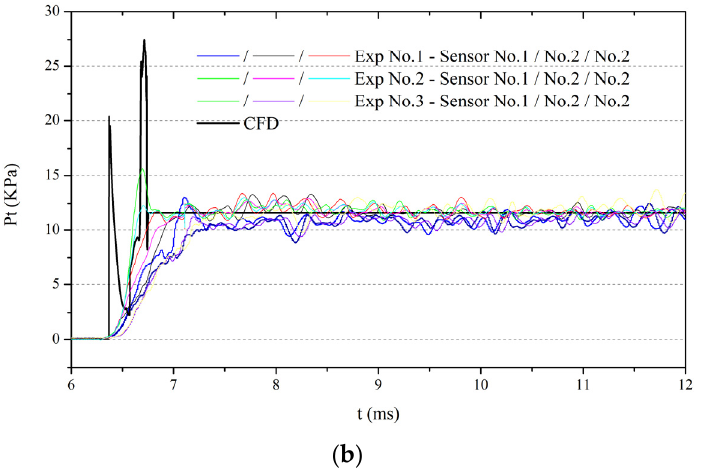
Figure 6. Comparison of the CFD (computational fluid dynamics) results and experimental data. ( a ) Heat Flux. ( b ) Pitot pressure.